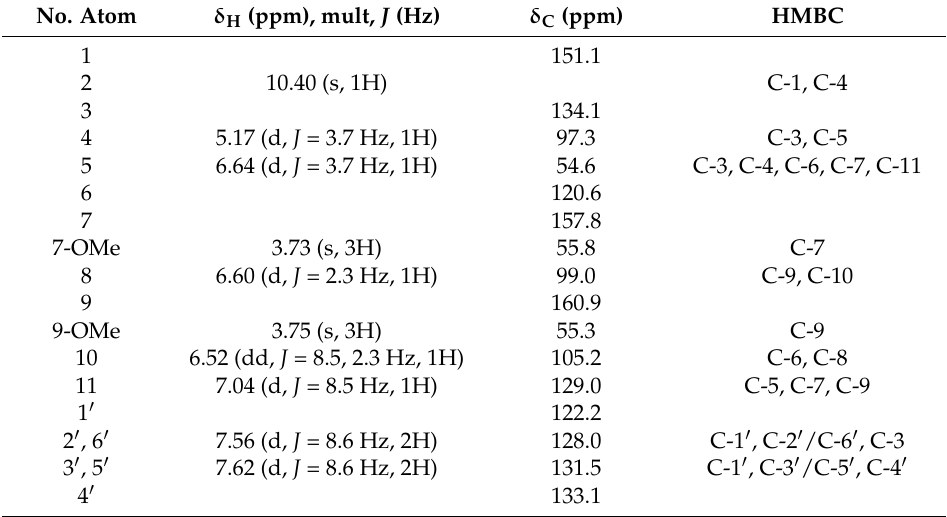
Figure 1. ( a ) Structure numbering, and ( b ) high-resolution mass spectrometry (HMBC) correlations of the prepared compound. Table 1. Nuclear magnetic resonance (NMR) data of the target compound ( 2 ) in DMSO- d 6 .